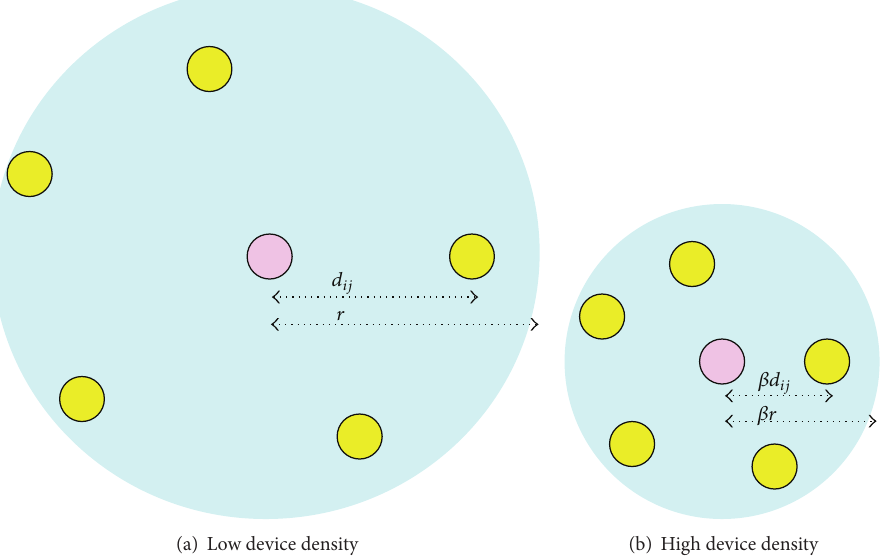
Figure 3: Device density with varying the distance between two